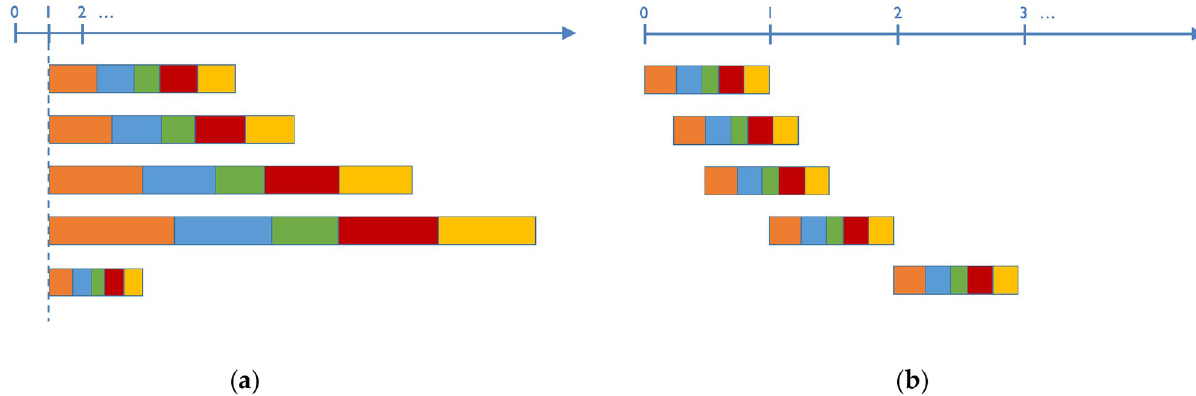
Fig 6. Attribute classification modification via (a) stretching, or (b)